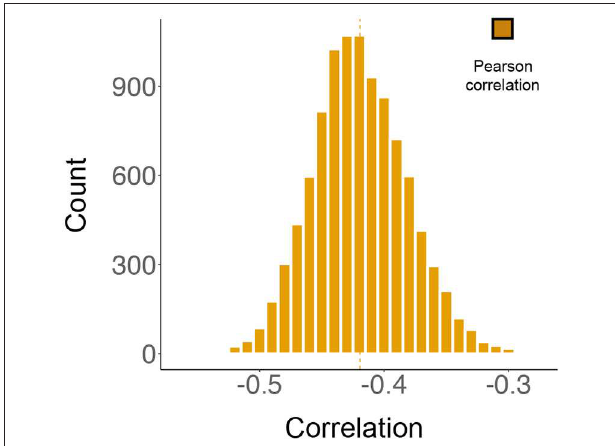
FIGURE 5 | The results from simulation studies. The histogram represents 10,000 correlations between the mean beauty ratings (m-BR) and the standard deviation of the beauty ratings (sd-BR), analyzed by Pearson’s test. During each simulation, non-negative integers generated from a Poisson distribution were added to (or subtracted from) the original ratings of 5 (or The 95% confidence interval for the distribution is (